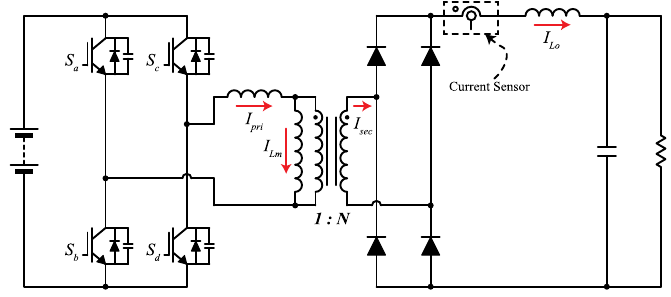
Figure 1. Secondary-side current detection of phase-shifted full-bridge (PSFB)